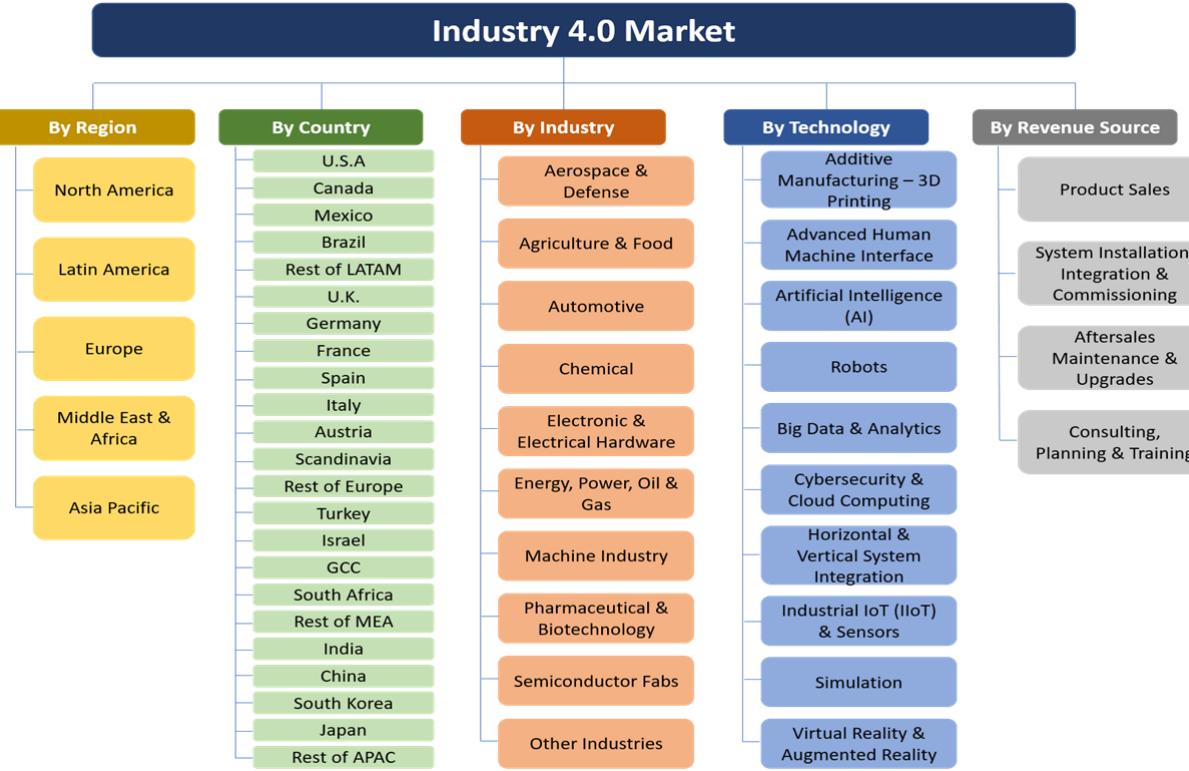
Figure 1. Industry 4.0 market - the overall implementation and